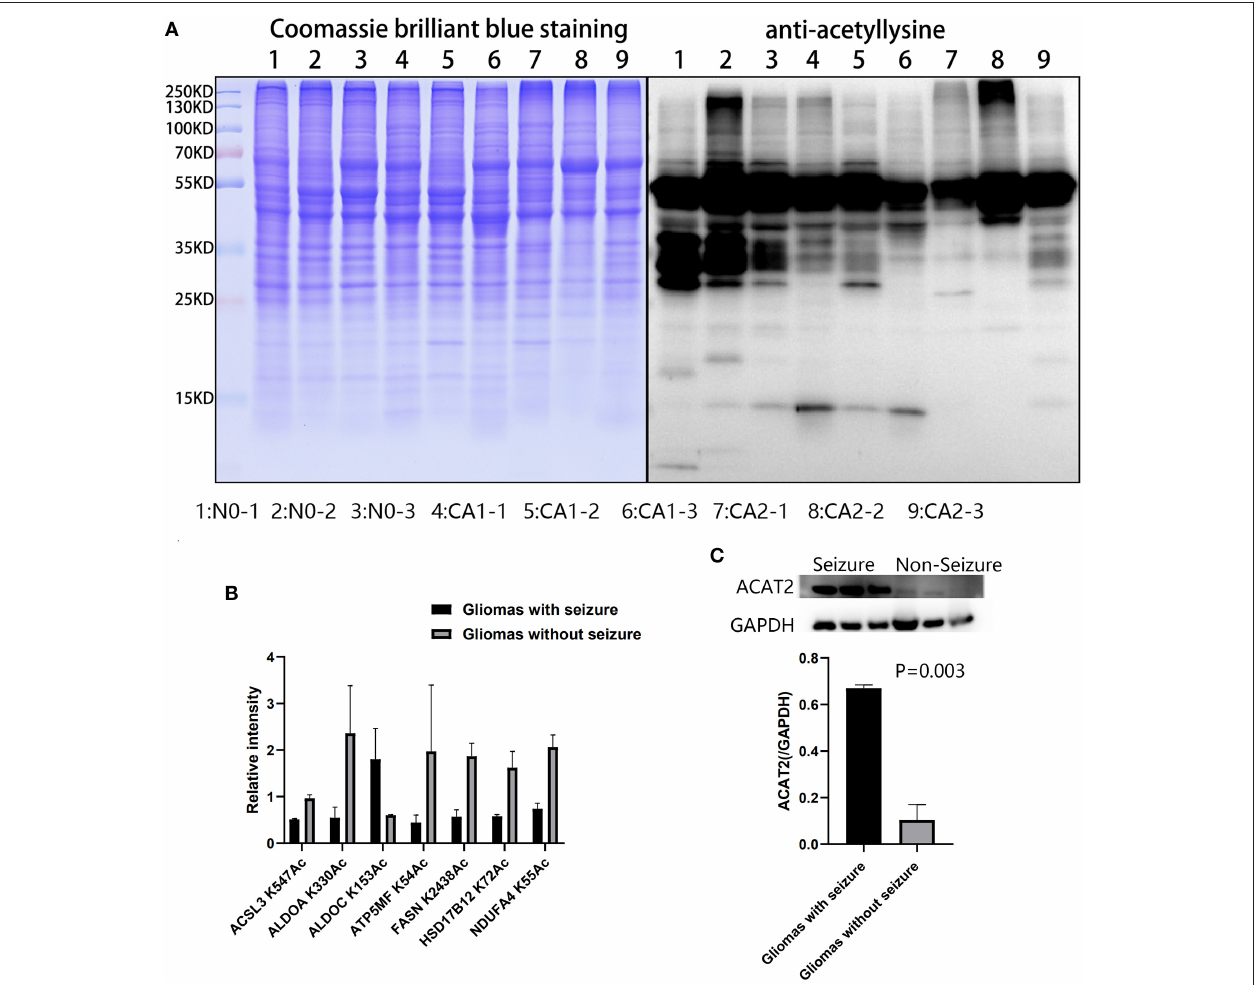
FIGURE 6 | Validation of acetylated profiles and proteomics by PRM and Western blot. (A) Acetylation differences of brain tissues and CA1 and CA2 samples were validated by Western blot. Acetylated proteins (15–55 KD) were significantly different. Samples 1, 2, and 3 were brain tissues surrounding gliomas. Samples 4, 5, and 6 were gliomas with seizures. Samples 7, 8, and 9 were gliomas without seizures. (B) Seven proteins were validated by PRM, including ACSL3 K547Ac, ALDOA K330Ac, ALDOC K153Ac, ATP5MF K54Ac, FASN K2438Ac, HSD17B12 K72Ac, and NDUFA4 K55Ac. (C) Upregulated ACAT2 in gliomas with seizures were validated by Western blot ( p =